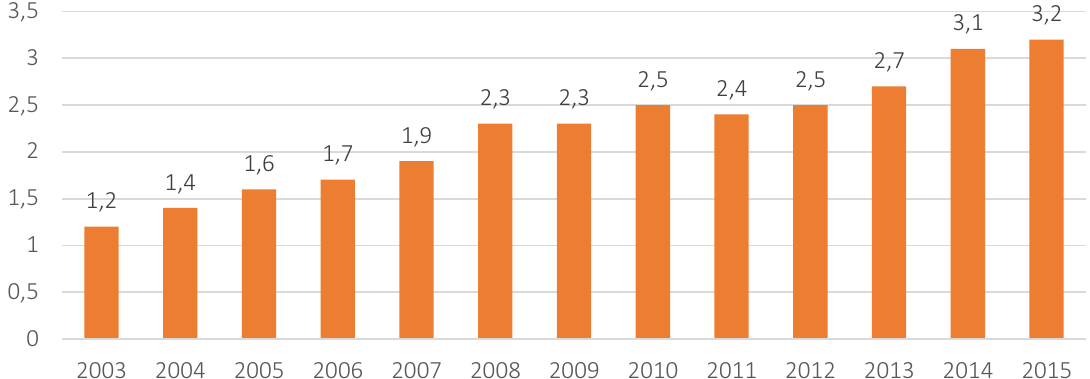
Figure 2. Costs of the company Nike on creating demand, 2003–2015, in billions of dollars